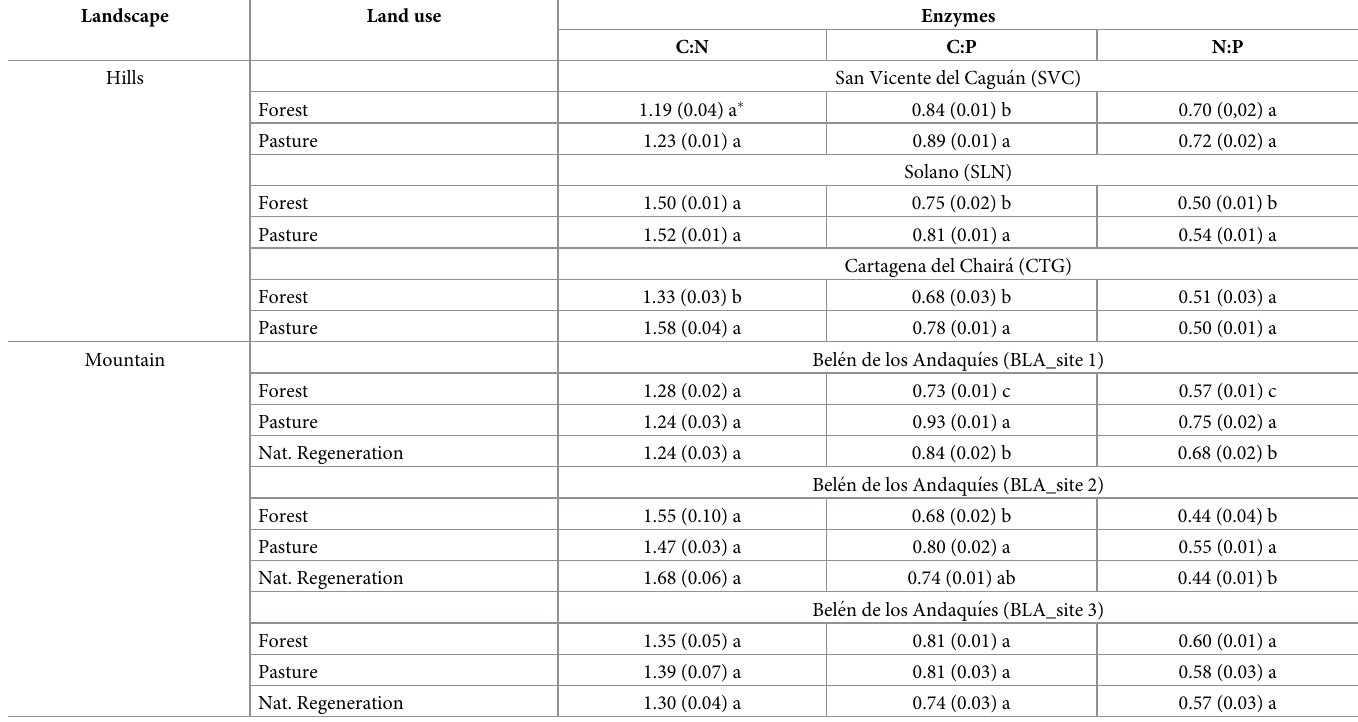
Table 5. Stoichiometry enzymes activity in soil under forest and pastures in Colombian Amazon region.